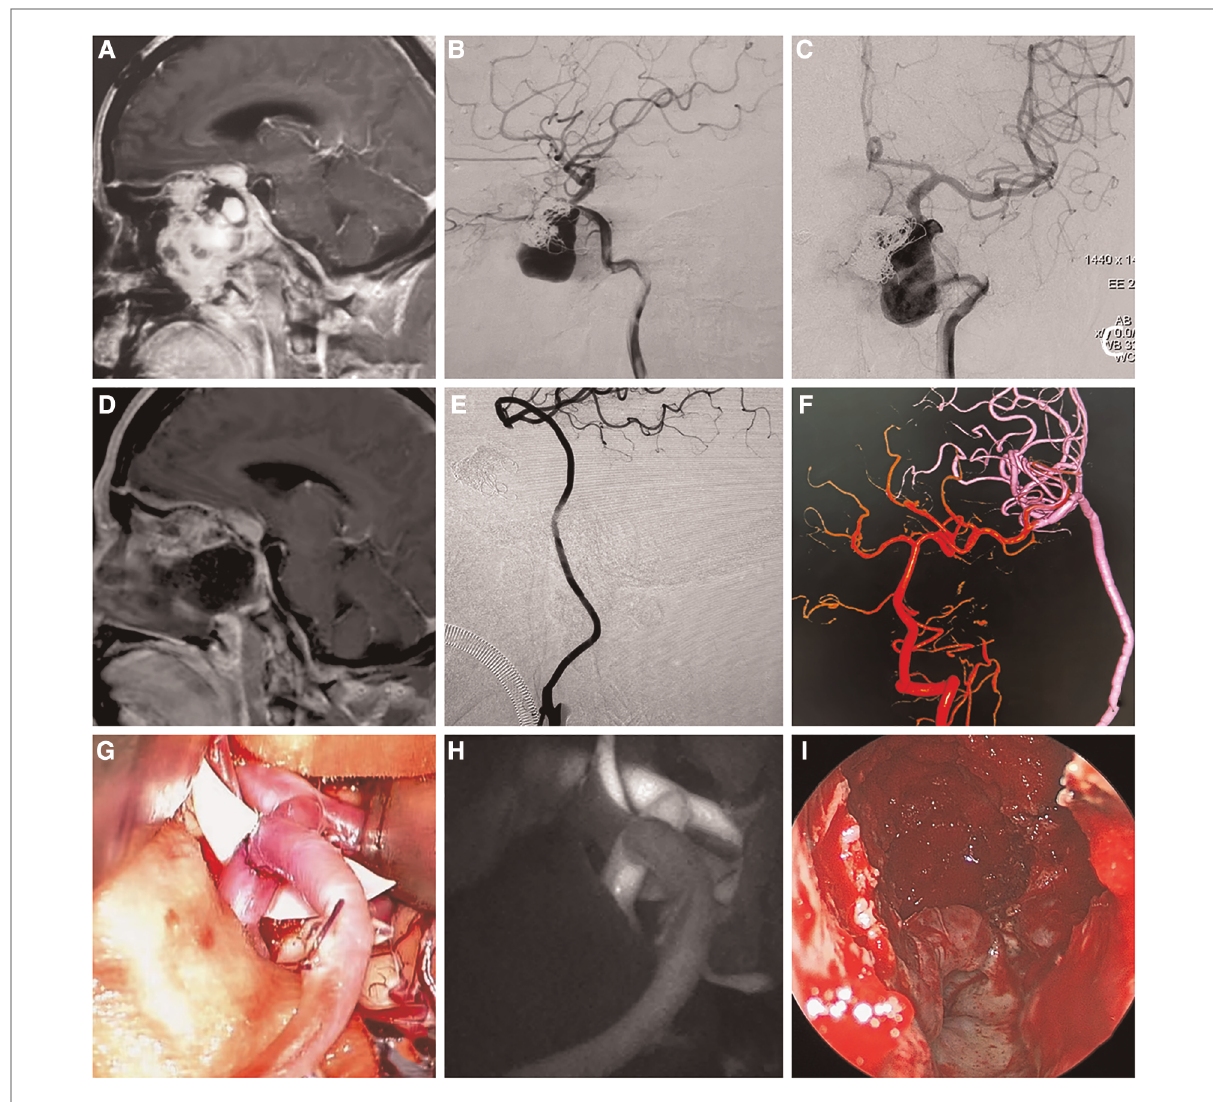
FIGURE 2 Images of a patient with recurrent fi brous dysplasia combined with internal carotid artery aneurysm who received Fukushima bypass type III (ECA-RA-M2) combined with transnasal endoscopic surgery to remove the affected bone, achieved optic nerve decompression and resection of the left internal carotid artery aneurysm. ( A ) Preoperative enhanced cranial magnetic resonance imaging (MRI) showing the internal carotid artery was invaded, and an aneurysm was formed. ( B, C ) Preoperative lateral and front digital subtraction angiography (DSA) projections showing the internal carotid artery and aneurysm. ( D ) Postoperative enhanced cranial MRI showing subtotal resection of the tumor and adequate decompression. ( E, F ) Postoperative cerebral DSA showing good patency of the radial artery graft, no visualization of ICA-C1 to ICA-C4 segments, and anterior cerebral circulation blood supply from posterior cerebral circulation. ( G ) Intraoperative image of Fukushima bypass type III (ECA-RA-M2). ( H ) Intraoperative fl uorescein angiography showing good patency of the radial artery graft. ( I ) Intraoperative images of endoscopic subtotal resection of